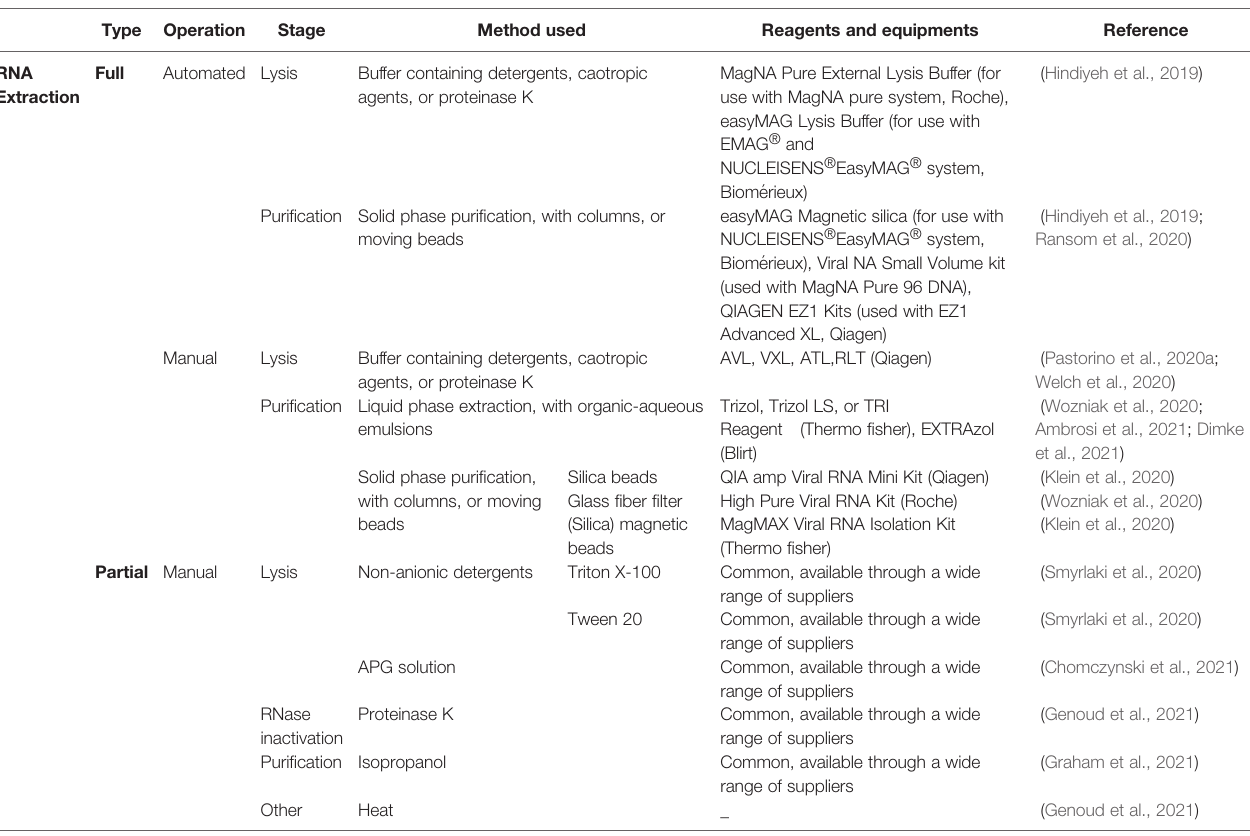
TABLE 2 | Comparison of distinct strategies for extracting viral RNA from clinical